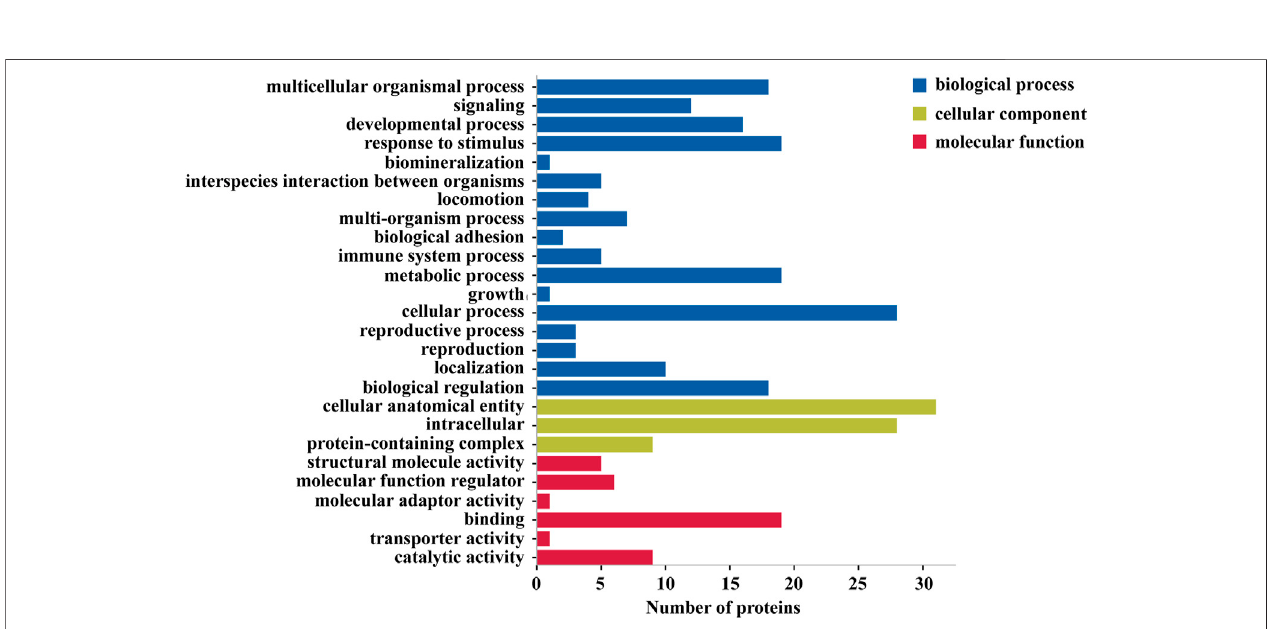
FIGURE 7 | Functional enrichment of Gene Ontology (GO) annotation for differentially expressed proteins. Blue represents the biological processes, green represents cell components, and red represents molecular functions.